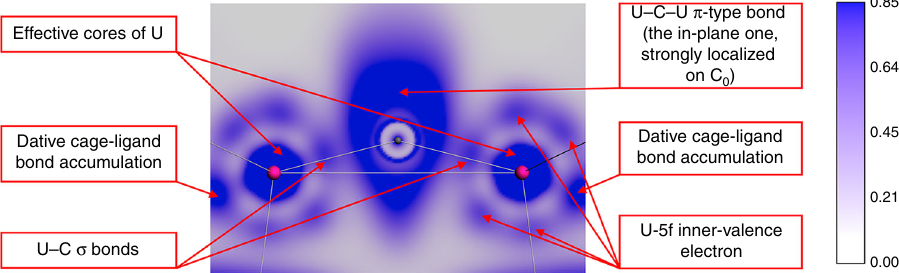
Fig. 3 ELF-plot of ligated UCU in the molecular plane. The left and right ligands are two (I 3 ) groups. ELF is the ‘ electron localization function ’ of Becke and Edgecombe, showing electronic accumulations in the inner atomic shells, in the atomic lone-pair regions, and in covalent and dative bond